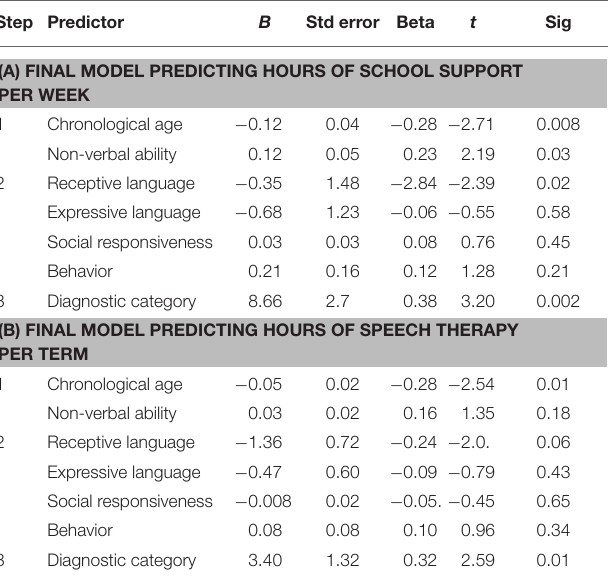
TABLE 5 | Exploratory regressions examining predictors for: (A) hours of support a week in schools; and (B) hours of support per term by